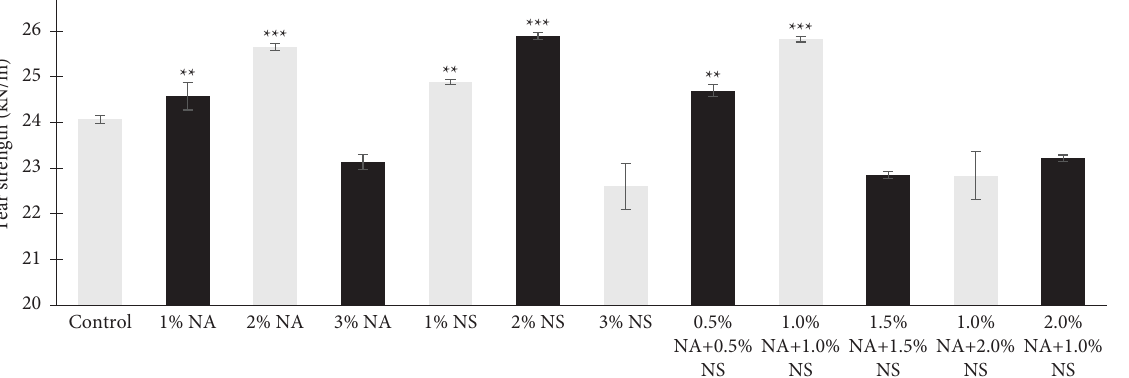
Figure 3: Tear strength for diferent wt. % of nanoalumina (NA), nanosilica (NS), and hybrid nanoparticle HySA. ∗∗ P < 0 . 01, ∗∗∗ P < 0 . 001.